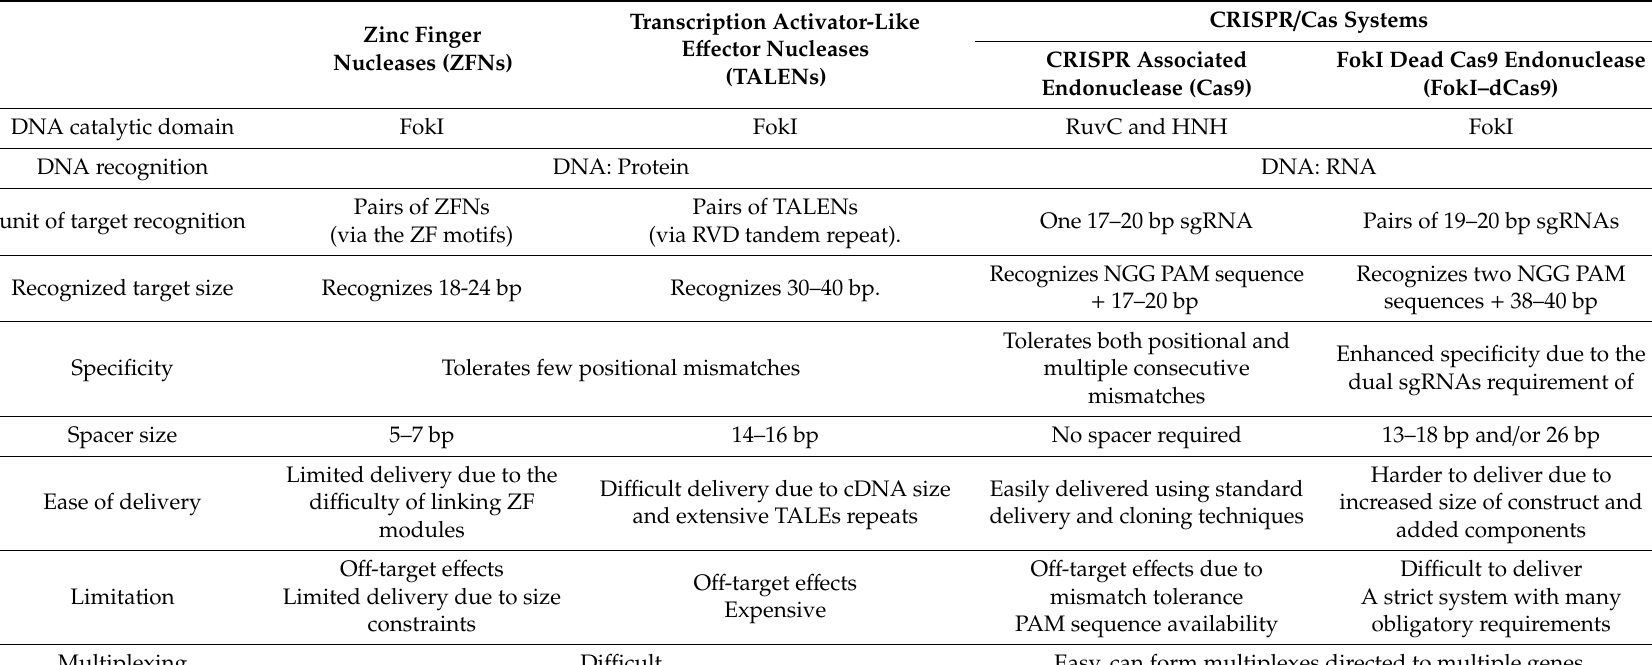
Table 1. Comparison between di ff erent gene-editing